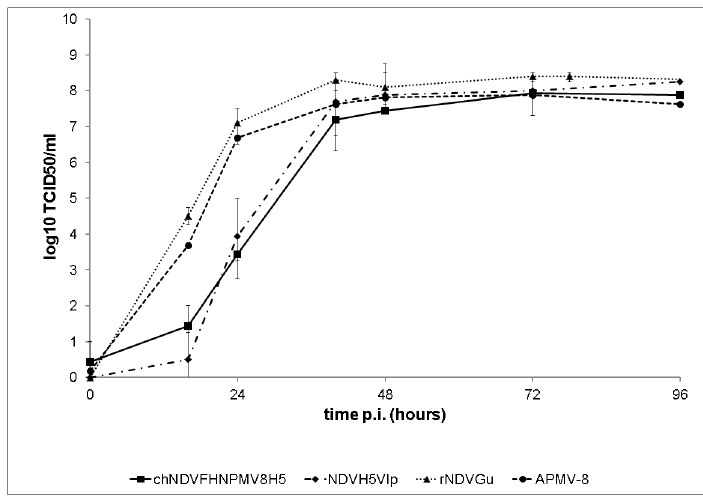
Figure 4. Kinetics of replication in ECE. Eggs were infected with 200 µl of a 10 3 TCID APMV-8, NDVH5Vlp, and rNDVGu, respectively. Allantoic fluids were harvested at indicated time points after inoculation. Titers of progeny virus were determined by titration on QM9 cells, followed by indirect immunofluorescence. doi: (Figure 7B, C). No NDV-specific antibodies were detected (Figure 7A), demonstrating lack of cross-reactivity between APMV-8 and NDV.